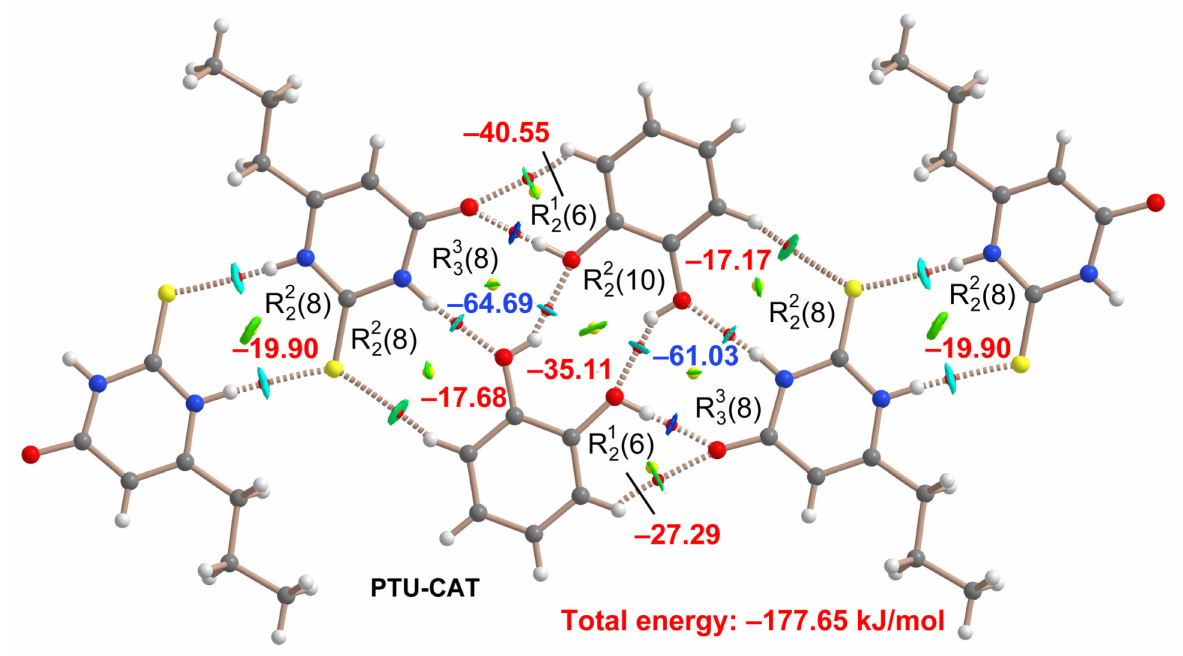
Figure 10. QTAIM/NCIPlot analysis of intermolecular bond and ring CPs (red and yellow spheres, respectively), bond paths, and RDG isosurfaces of the H-bonded assembly of PTU–CAT cocrystal. The individual association energies of each synthon are indicated using a red or blue font inside the supramolecular